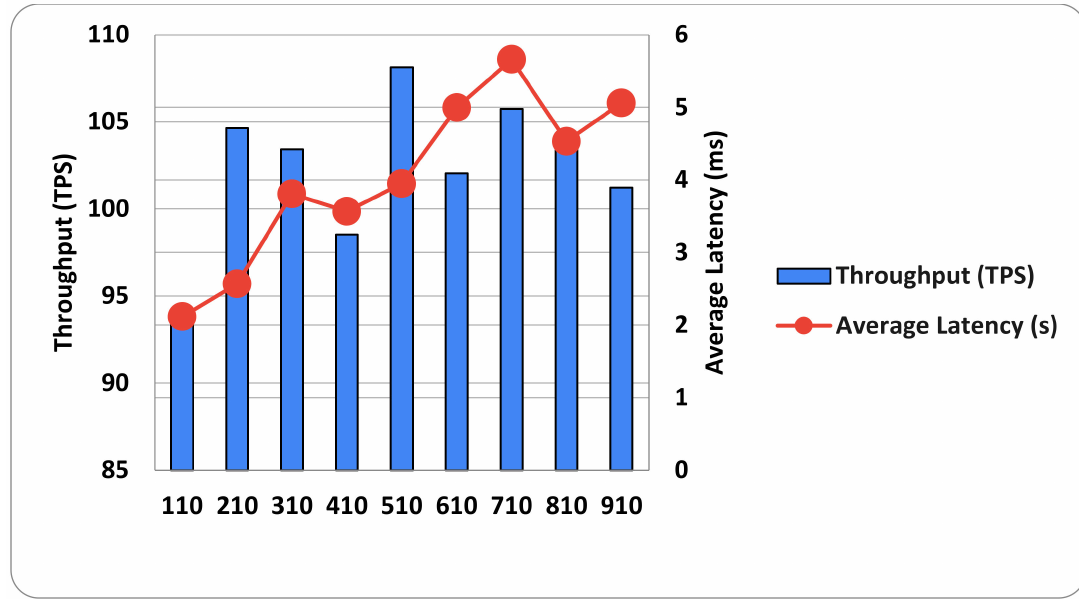
Figure 9. Various send rates for write latency and write